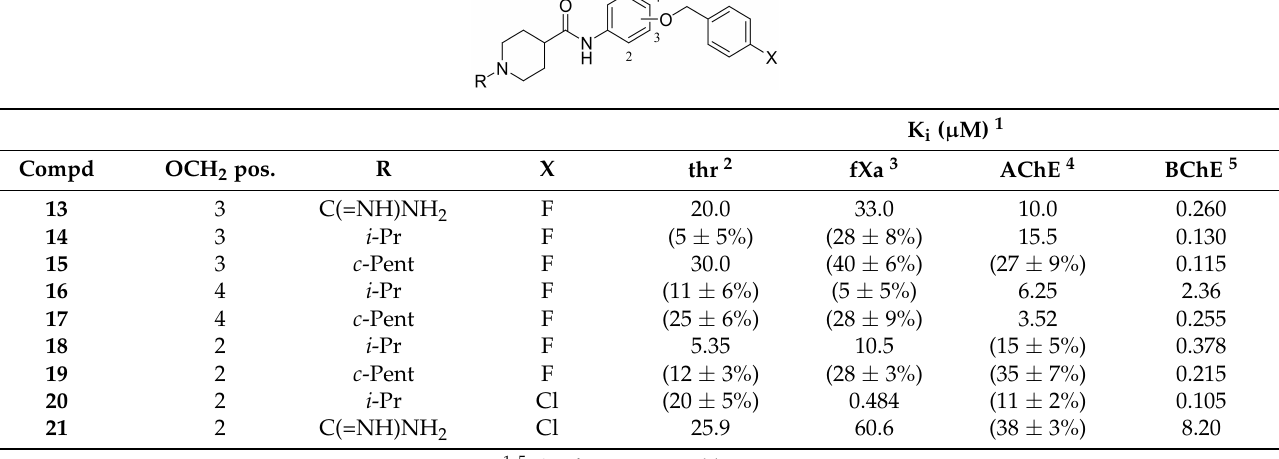
Table 3. Anticholinesterase activity of isonipecotanilide-based fXa selective inhibitors.